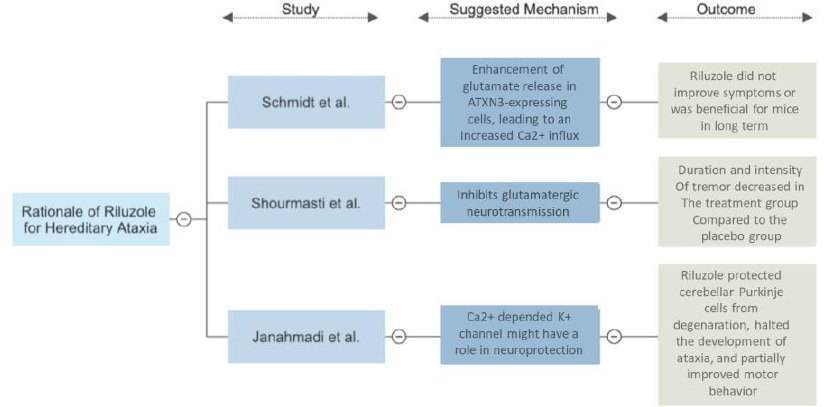
Figure 3. Rationale of Riluzole for Hereditary Ataxias; Comparison of the 3 studies included, suggested mechanism, and